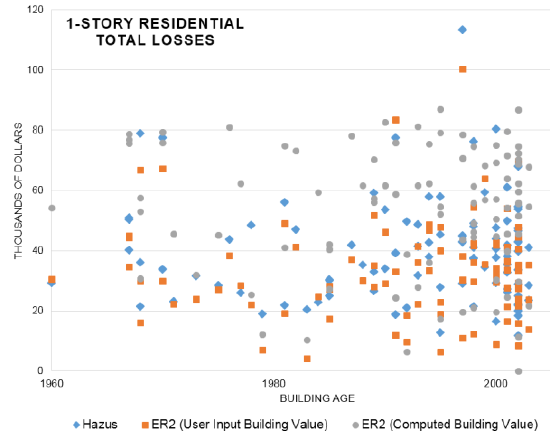
Figure 11. Total Damages versus water depth for Hazus, ER 2 using user input building value and ER 2 using computed building value by building